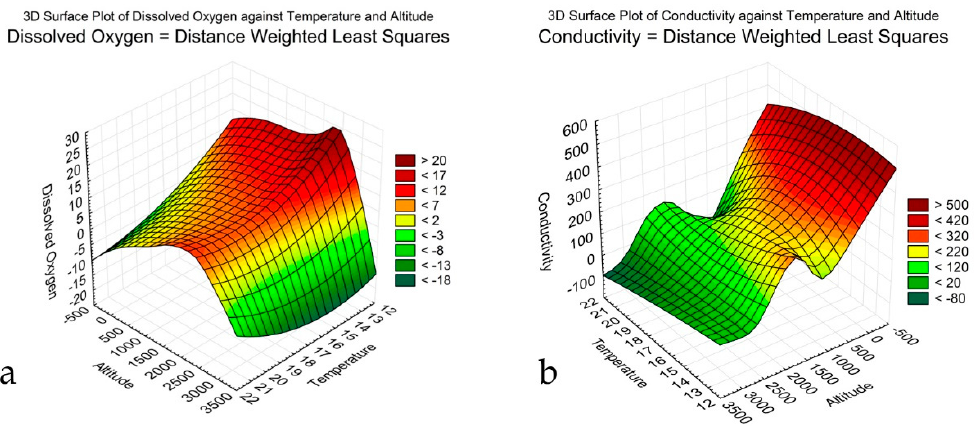
Figure 11. Distribution of major environmental variables over altitude of the lakes in Rize province, the Artabel Lakes in Gümü ş hane province, and other lakes in northern Turkey based on Table 3. Distance Weighted Least Squares dependence of environmental parameters: ( a ), dissolved oxygen and water temperature and altitude; ( b ), water conductivity and temperature and altitude.